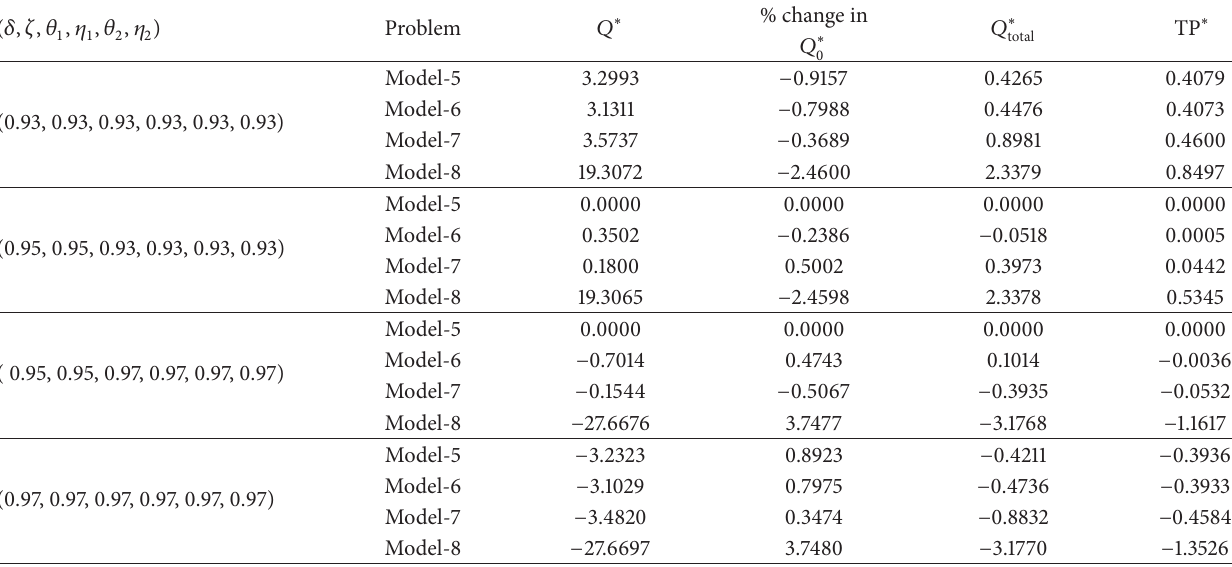
Table 8: Effect of predetermined level on the optimal